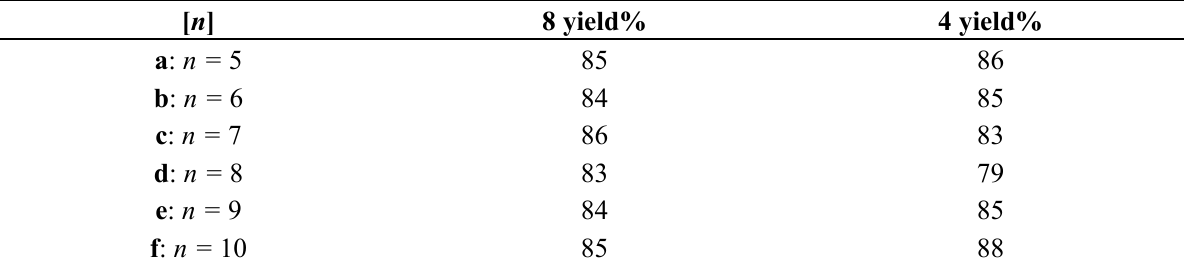
Table 4. Hydrogenation and elimination of compound 3 to yield products 8 and 4